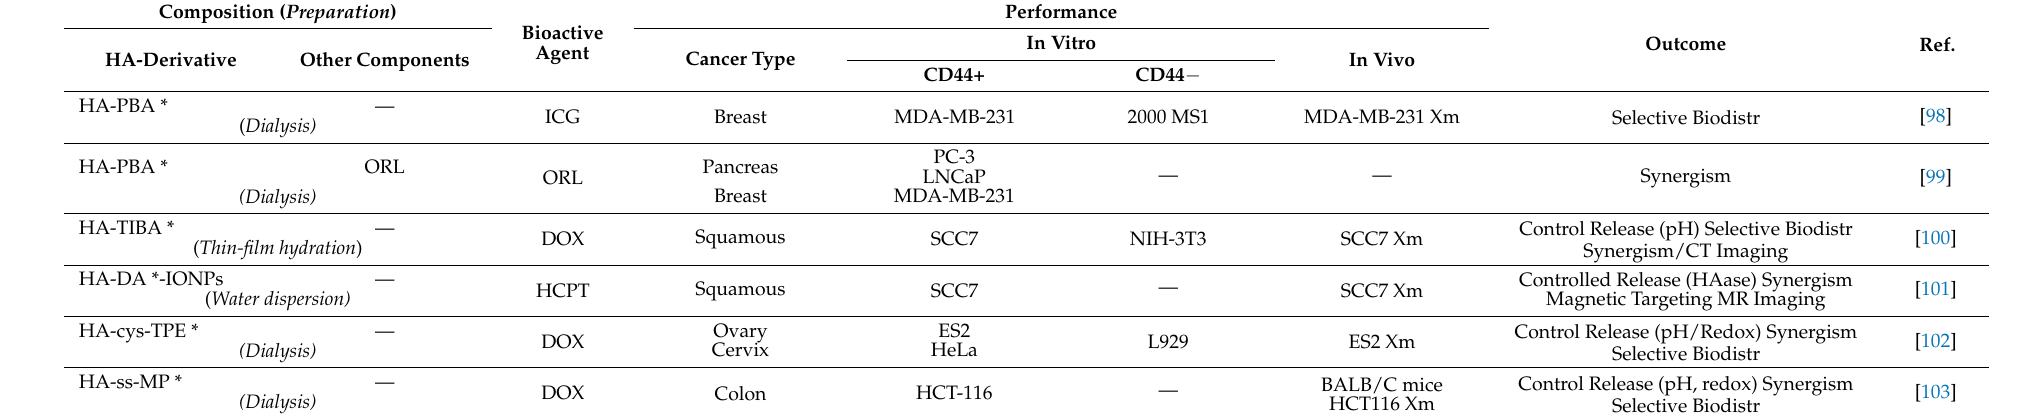
Table 4. HA-SANPs obtained by hydrophobic interactions of phenyl-modified HA.